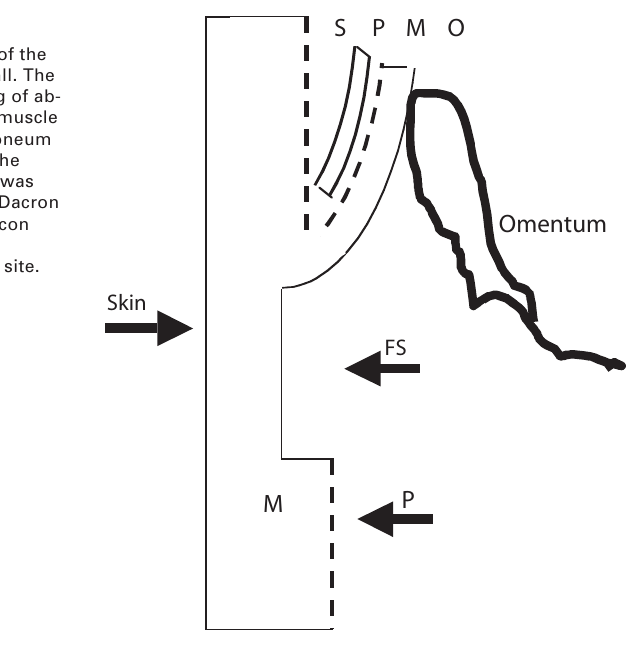
Sagittal view of the abdominal wall. The flap consisting of ab- dominal wall muscle (M) and peritoneum (P) based on the omentum (O) was overlaid with Dacron reinforced silicon graft (S). FS; dissected flap site.